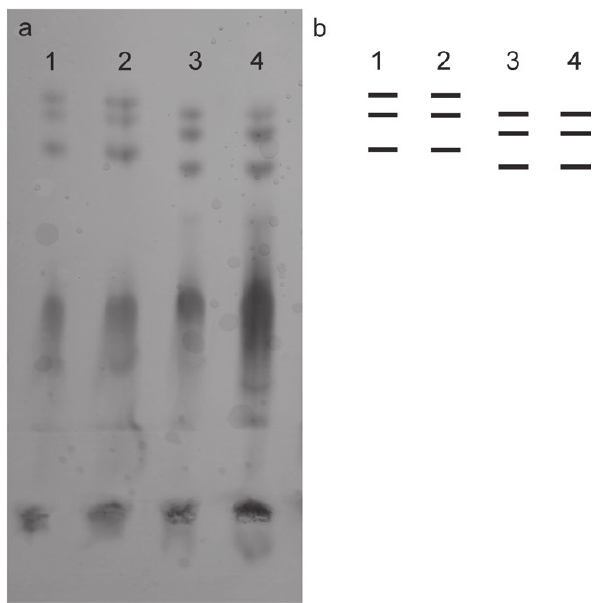
Figure 2. a) Esterase and malate dehydrogenase phenotypes, and b) schematic representation of Meloidogyne inornata (lanes 3 & 4). Lanes 1 & 2: M. javanica (reference